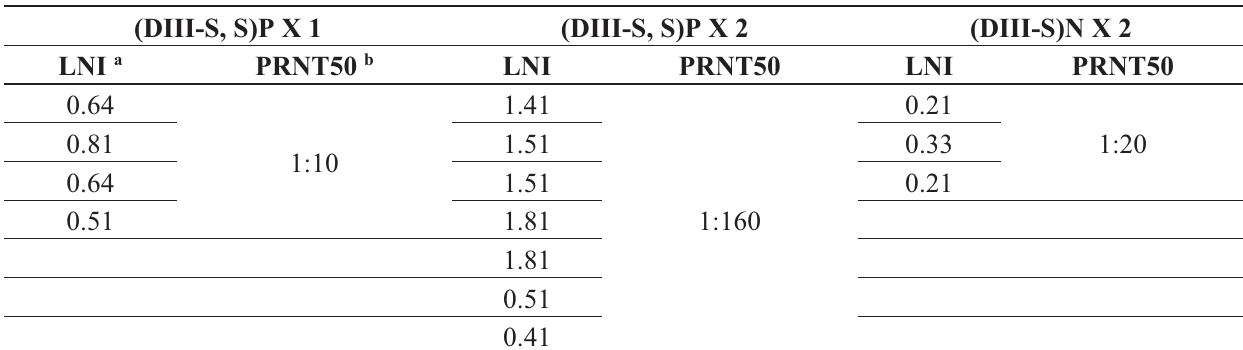
Table 2. Anti Dengue 2